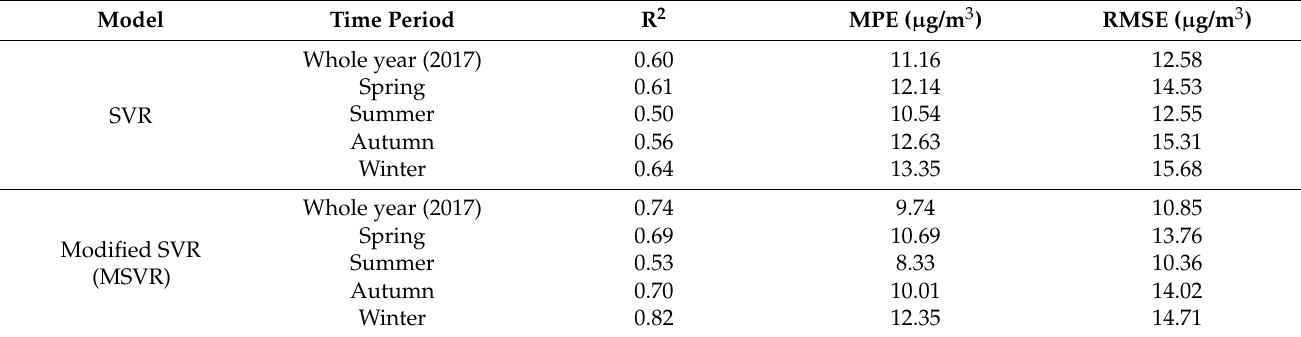
Table 4. Accuracy comparisons between SVR and MSVR for different seasons and the entire year in 2017. Model